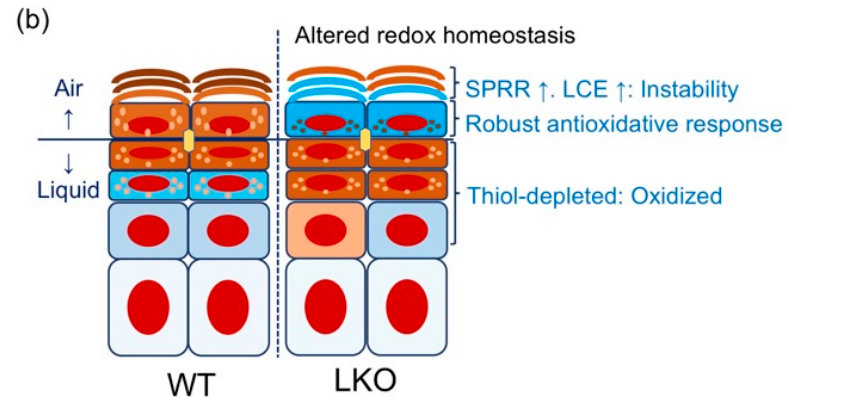
Figure 3. ( a ) The primary structure of murine LOR, SPRR2, and LCE1. LOR is a major CE component that contains high amounts of glycine (G; 55%), serine (S; 22%), and cysteine (C; 7%) arranged in tandem peptide quasi-repeats. These repeats are separated by highly conserved lysine (K) and glutamine (Q) residues that are substrates for transglutaminase-mediated ε -( γ -glutamyl) lysine cross-linkage. The consensus sequence of the SPRR2 family comprises almost entirely of proline (P), Q, K, and C. The consensus sequence of the LCE1 family suggests high amounts of P (~12%), as well as G (~20%) and S (~25%), suggesting that LCE1s have evolved as hybrids between LOR and SPRR2s. The H / R-rich region is reminiscent of FLG, which provides the precursor of natural moisturizing factors. ( b ) Schematic representation of altered redox homeostasis in LKO epidermis.